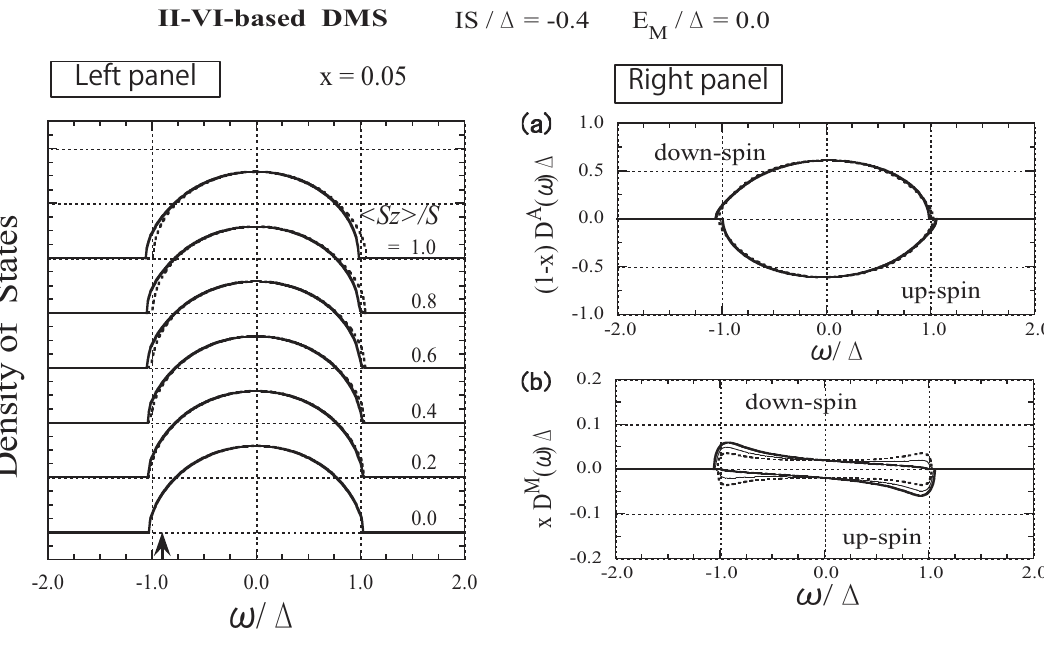
The results for II-VI-based DMSs. Left panel: DOS as a function ⟩ =S . The solid lines represent the down-spin of != ∆ for various values of ⟨ S z carrier and the dotted lines represent the up-spin carrier. The arrow indicates = ∆ for n = x (= 0 : 05) . Right panel: (a) A -site component the Fermi level " F ( ! )∆ and − (1 − x ) D A ( ! )∆ . (b) M -site component of the DOS, (1 − x ) D A ↓ ↑ ( ! )∆ and − xD M ( ! )∆ . The thick, thin, and dotted lines of the DOS, xD M ↓ ↑ ⟩ =S = 1 : 0 , 0 : 5 , and 0 : 0 , respectively. From Takahashi represent the cases of ⟨ S z and Kubo